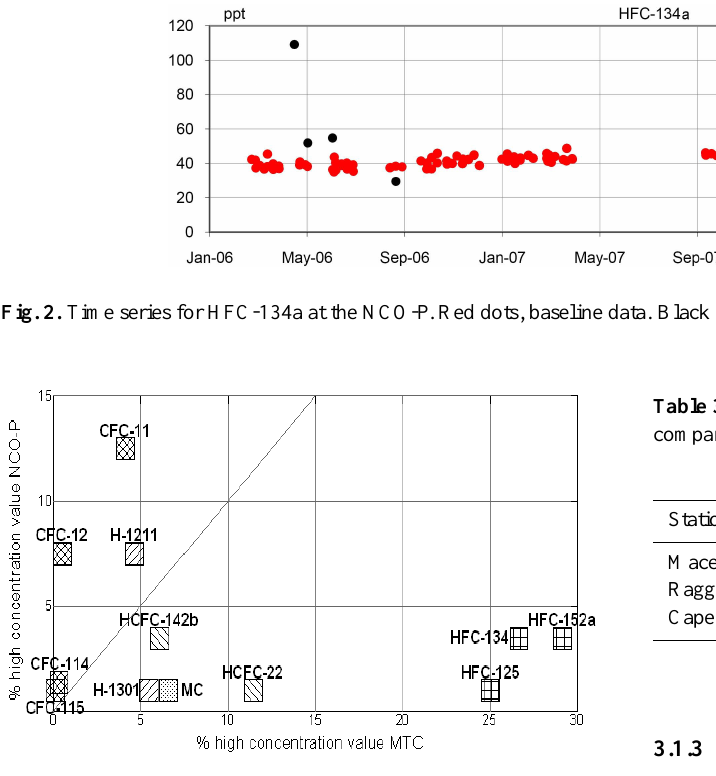
Fig. 3. Scatter plot of the percentage of occurrence of high concen- tration peaks at NCO-P and MTC observatories. Chemically homo- geneous classes of compounds are denoted by identical shadings.